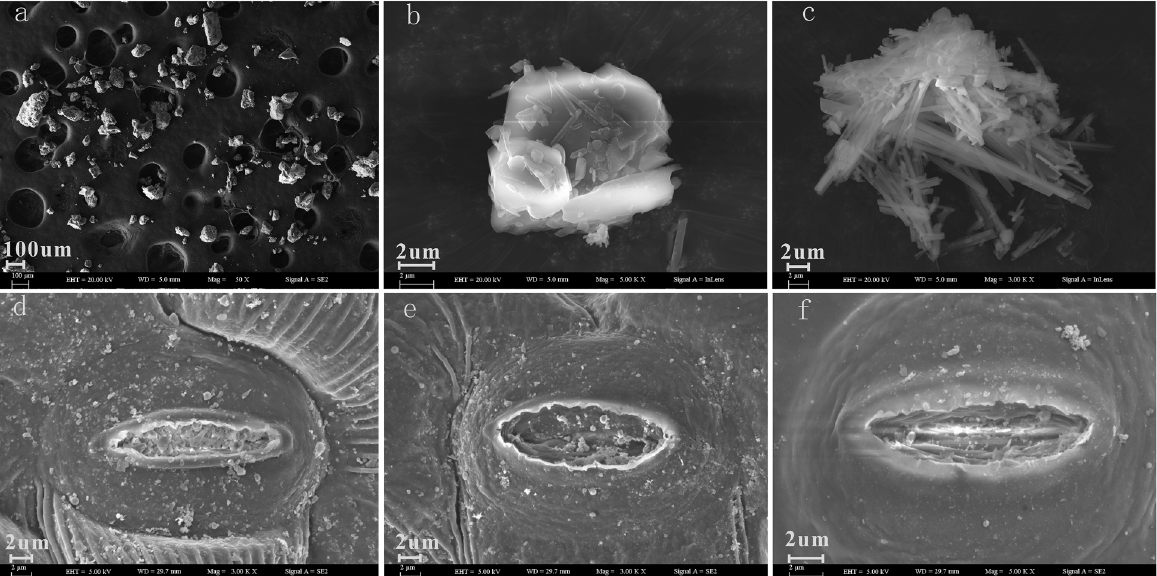
Fig 4. The surface morphology of the cotton